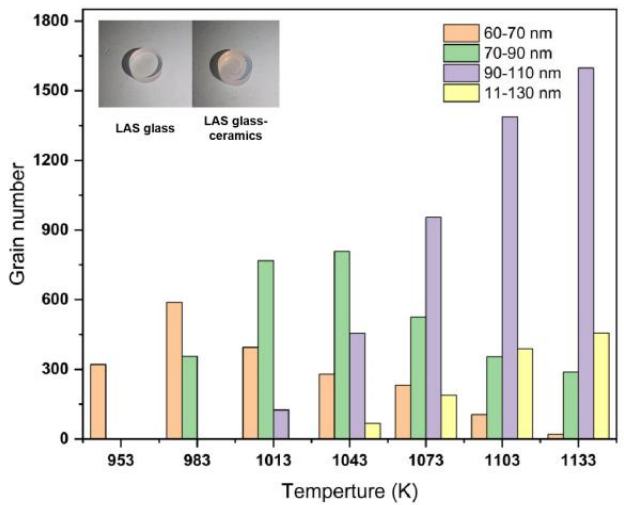
Figure 7. Grain size and number at different